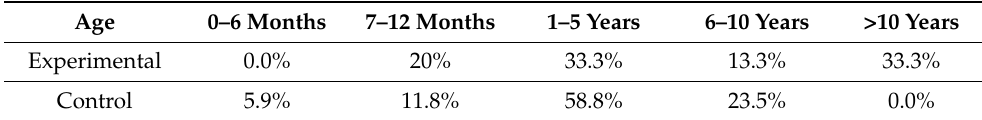
Table 2. Age of male dogs (experimental and control